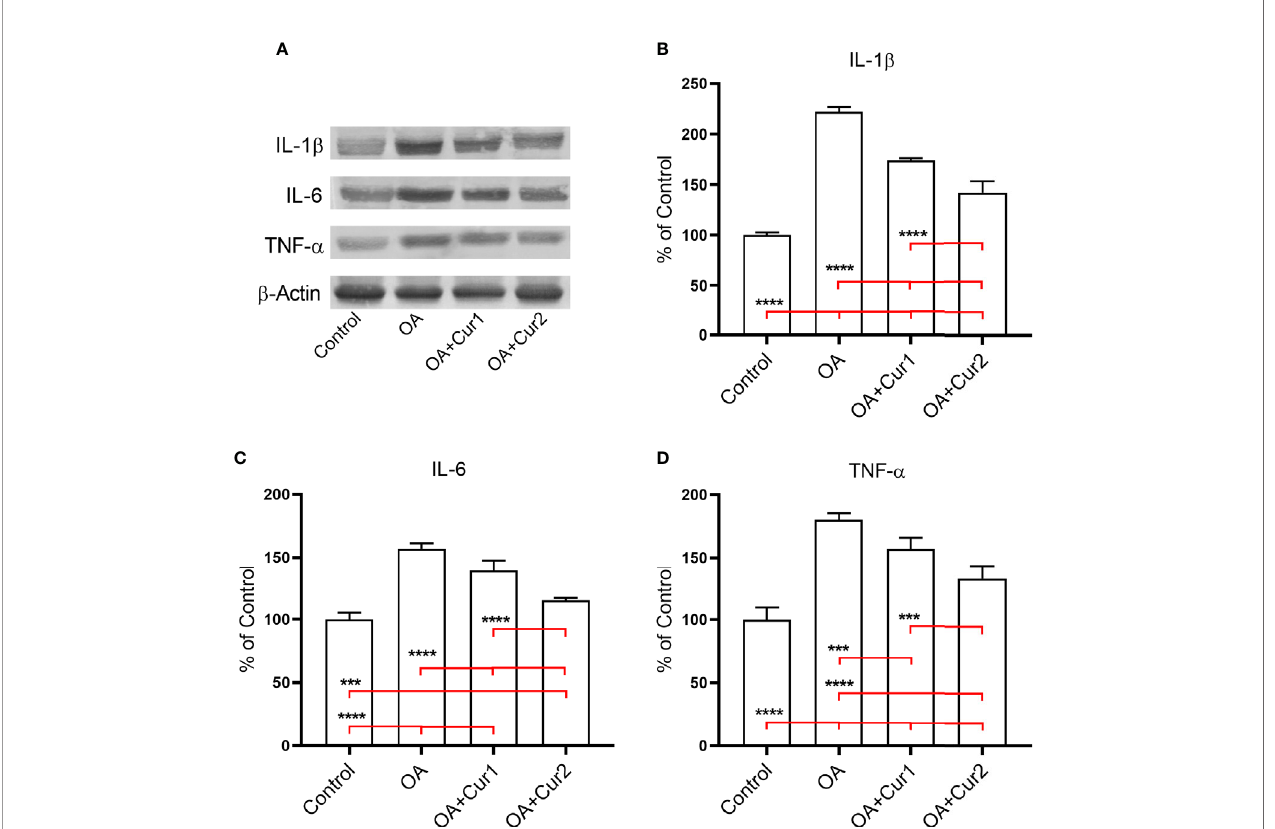
FIGURE 5 | Effects of Next Generation Ultrasol Curcumin (NGUC) supplementation on protein expressions of pro-in fl ammatory mediators in rats with monosodium iodoacetate (MIA)-induced OA. (A) Representative protein expressions of IL-1 b , IL-6 and TNF- a levels in synovial tissue of rats. b -actin was referenced to ensure equal protein loading. Graphs demonstrate densitometric analysis of the western blots for (B) IL-1 b , (C) IL-6 and (D) TNF- a . Data represent percent of the control values. Blots were repeated at least three times. Statistical differences among the groups were determined by one-way ANOVA followed by a post-hoc Tukey test;